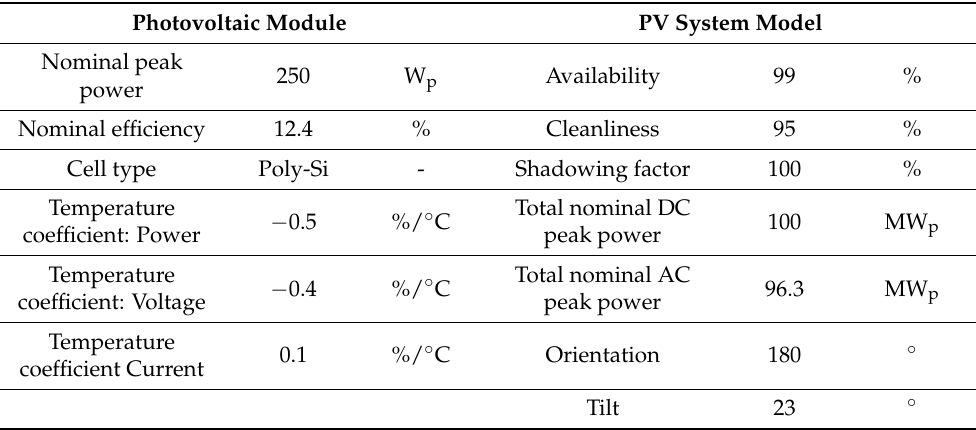
Table 3. Technical details of the technology employed for the “base” PV system